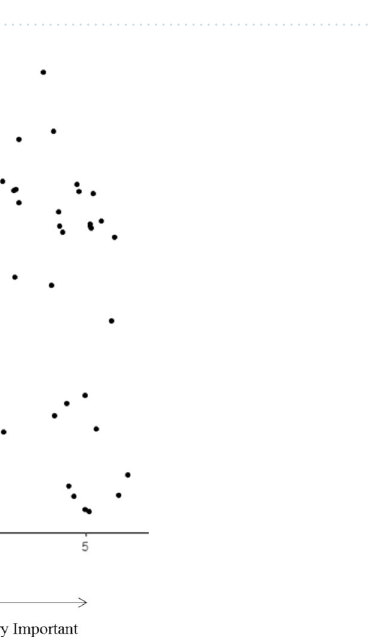
Figure 2. The relationships between the number of wildlife seen while recreating in riparian areas and by high/low visitor use (n = 47). ( A ) Wildlife observances significantly increased with increasing riparian area. ( B ) Wildlife observances significantly increased on low visitor use days compared to high visitor use. Both figures are plotted using the residual change in total wildlife seen when controlling for riparian area, as well as recreational crowding.